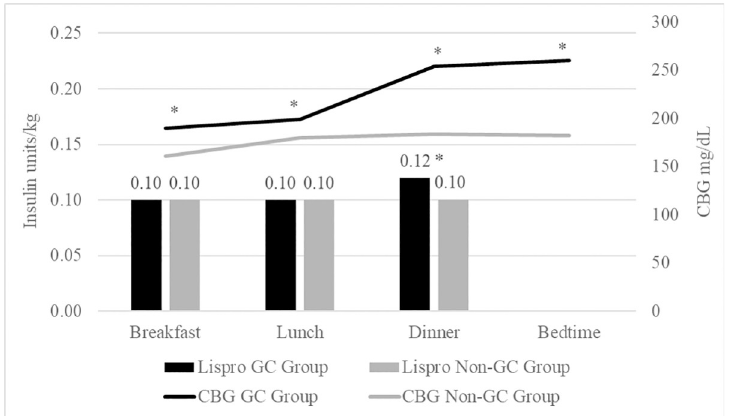
Fig 2. Mean capillary blood glucose (CBG) readings at mealtimes and bedtime and median insulin lispro doses at mealtimes. � P < 0.05 between glucocorticoid (GC) and non-GC mealtime glucoses at same mealtime. �� P < 0.05 between GC and non-GC lispro dose at